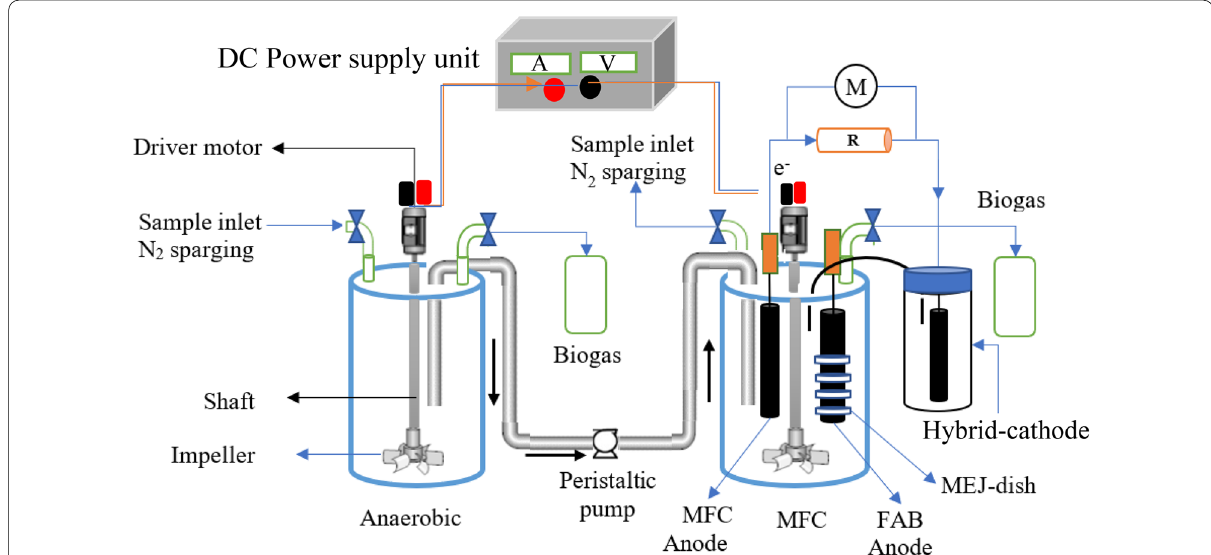
Fig. 2 The schematic diagram for a semi-continuous anaerobic-microbial fuel cell (anaerobic-MFC) integrated treatment system. The second air–cathode chamber was not shown to simplify the diagram. M a multimeter, FAB fragmented anode biofilm, MEJ-dish a microbial electrode jacket dish. Arrows indicate the wastewater flow path